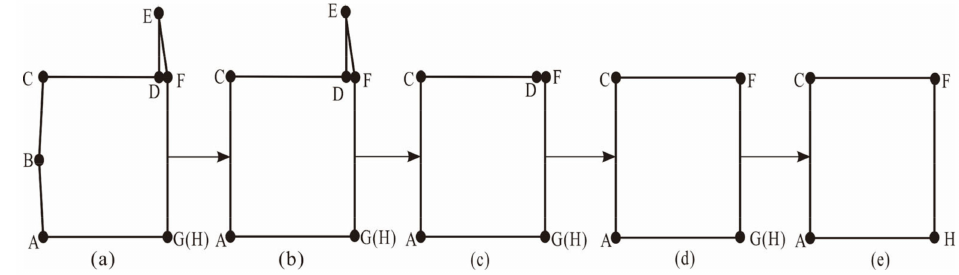
Figure 3. Preprocessing for buildings. ( a ) 0riginal polygon; ( b – e ) Preprocessing for buildings to remove abnormal nodes.